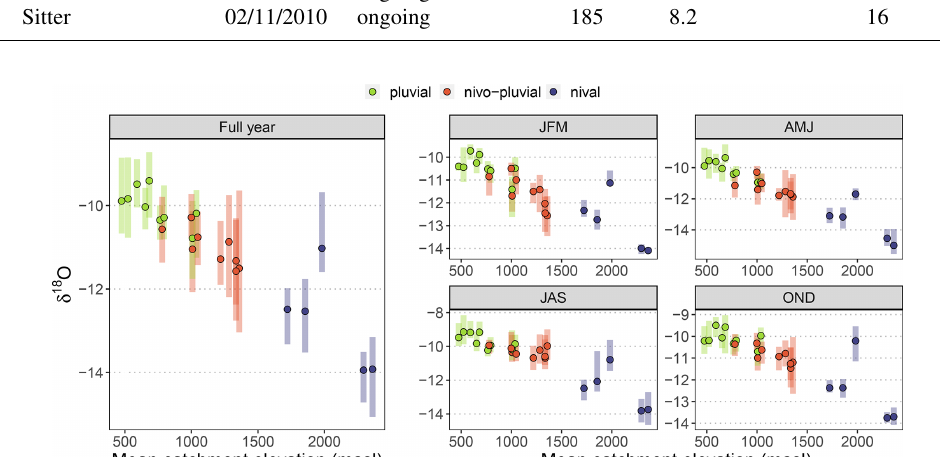
Figure 5. Median and ranges (10th and 90th percentile) of δ 2 H for the full sampling period (left) and separately for the seasons (right) of the samples for each catchment against the mean catchment elevation. The colours indicate the regime type to which the catchments were